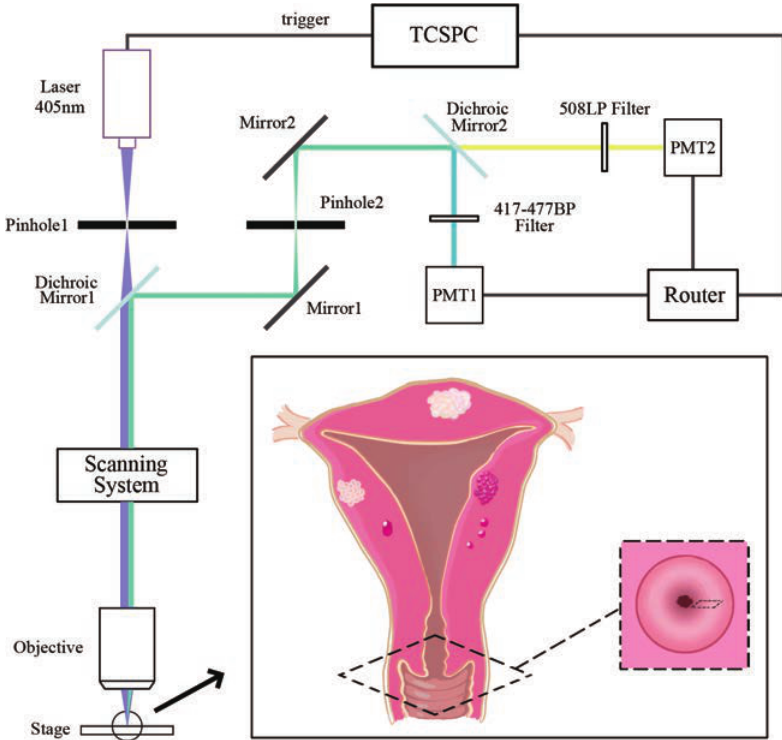
Fig. 1. Schematic of the two-channel TCSPC FLIM system for detecting benign uterine tumors though adjacent healthy cervical